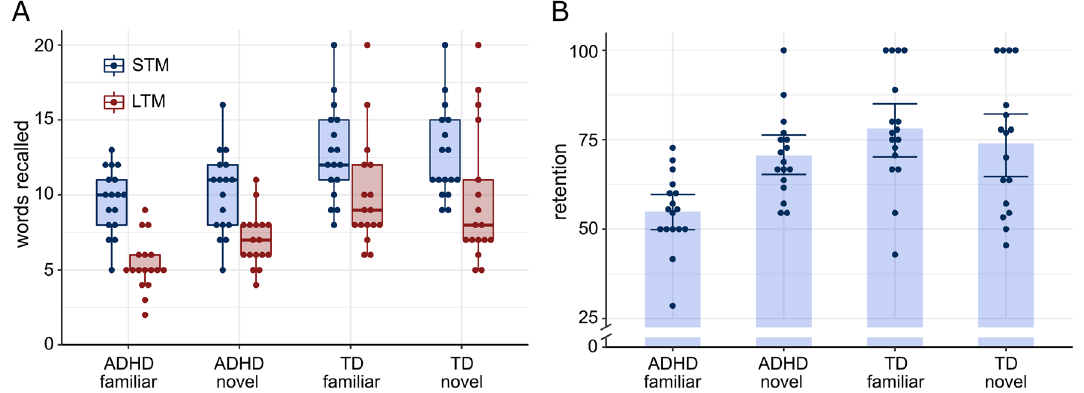
Figure 2. STM and LTM free recall scores with boxplots ( A ) and retention scores with means and 95% confidence intervals ( B ). Retention represents the percentage of words retained from STM to LTM (retention = LTM/STM * 100). Across a delay of 24 h, children and adolescents with ADHD retained a higher percentage of words if they explored a novel compared to a familiar environment (indicating improved memory consolidation). This effect was not observed for typically developing children and adolescents. Dots represent single participants, STM = short term memory, LTM = long term memory, TD = typically